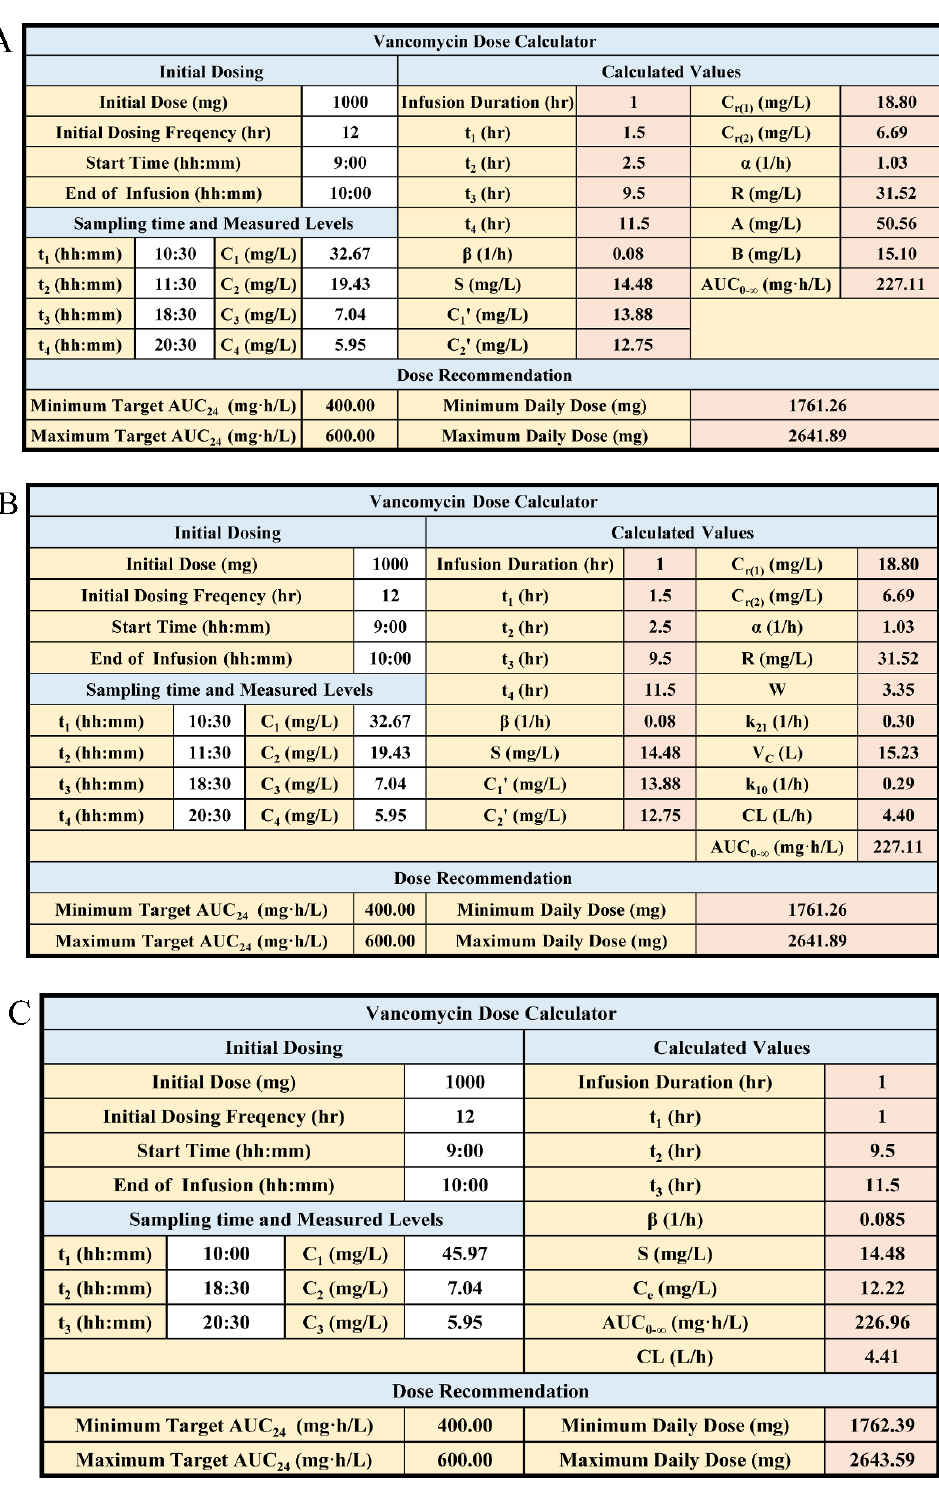
Figure 6. Screenshot of the calculators based on Method 1 and Method 2. ( A ) Method 1, approach 1; ( B ) Method 1, approach 2; ( C ) Method 2. White cells in the upper portion in the table are the patient-specific information. The blocks in pink would be auto populated. After calculating AUC 0– ∞ , the recommended daily dose to target the minimum and maximum PK/PD index would be displayed in the cell on lower right.